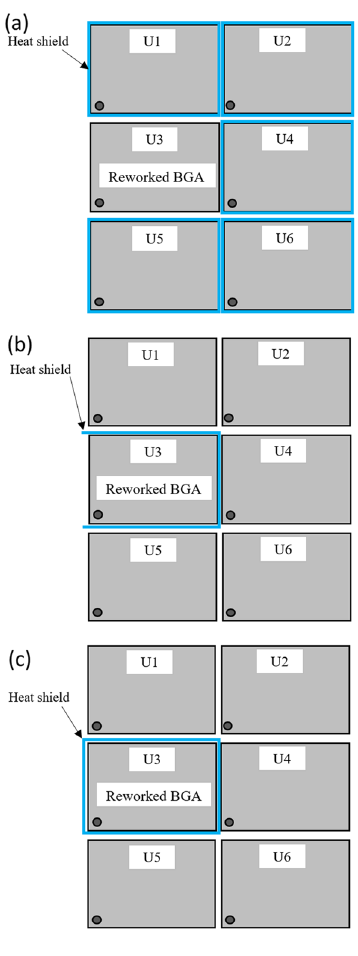
Figure 8. Schematic of heat shield(s) placement locations: ( a )—an individual heat shield on adjacent components of the rework location; ( b )—a U-shaped heat shield on the rework component; ( c )—a square- shaped heat shield on the rework component.